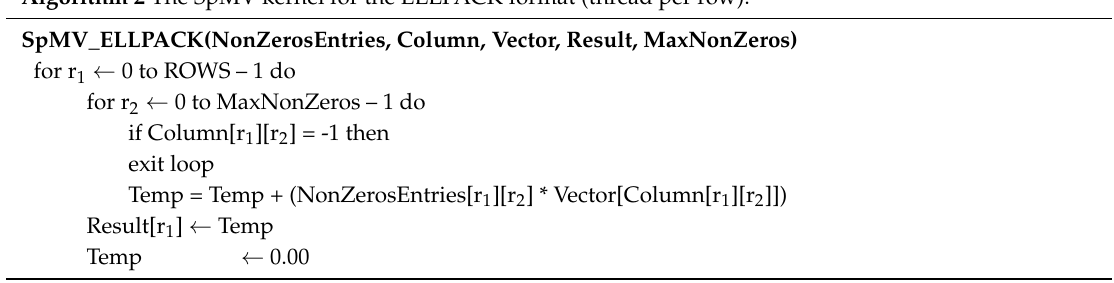
Algorithm 2 The SpMV kernel for the ELLPACK format (thread per